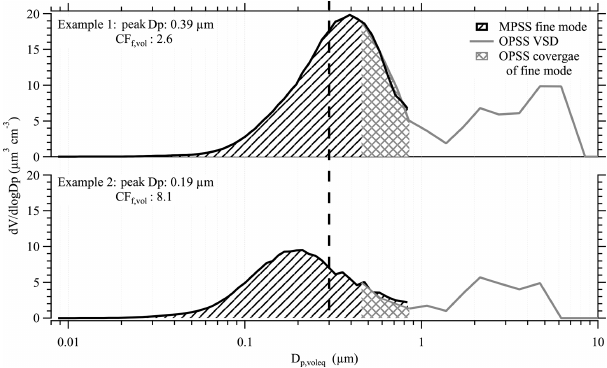
Figure 9. Dependence of the OPSS coverage of the fine mode on the variability of the fine-mode peak